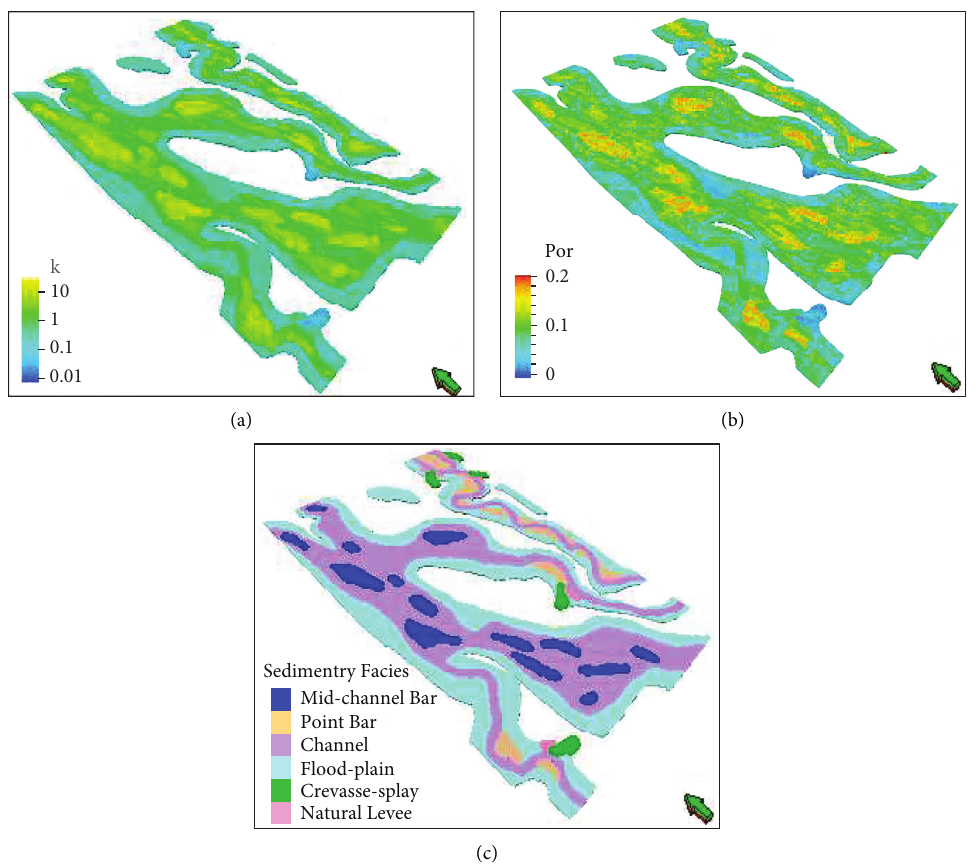
Figure 8: Relationship among porosity, permeability, and facies. (a) Distribution of permeability of the 1 st layer. (b) Distribution of porosity in the 1 st layer. (c) Distribution of sedimentary facies in the 1 st